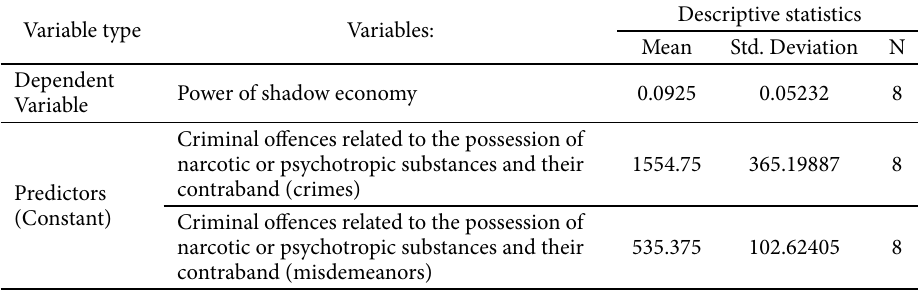
Table 2. Correlation analysis and model of the statistics of shadow economy power and criminal offence activity variables in 2005–2012 s o r c t d i e p r o f h r t n b e i m u N Criminal offences related to the possession of narcotic or psychotropic substances and